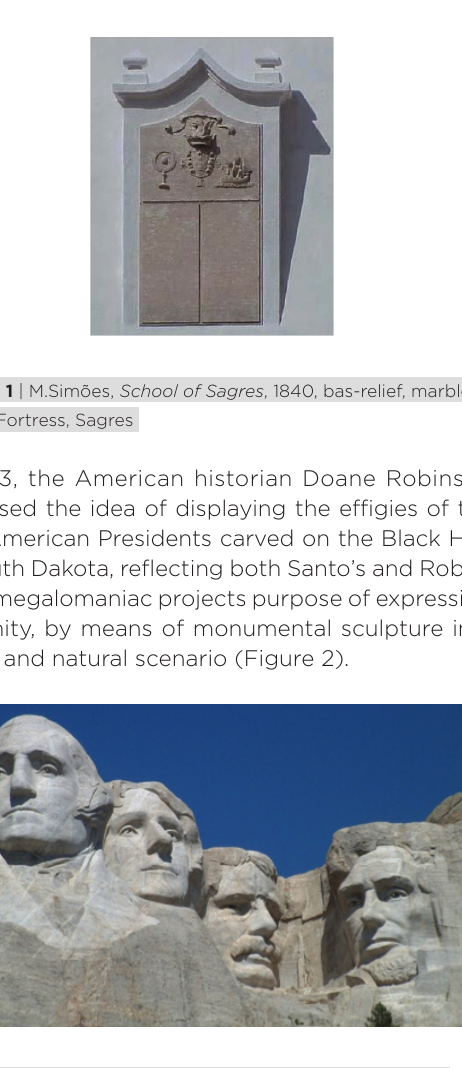
FIGURE 2 | G. Borglum, Mount Rushmore Memorial, 1927-41, Keystone, South Dakota, USA